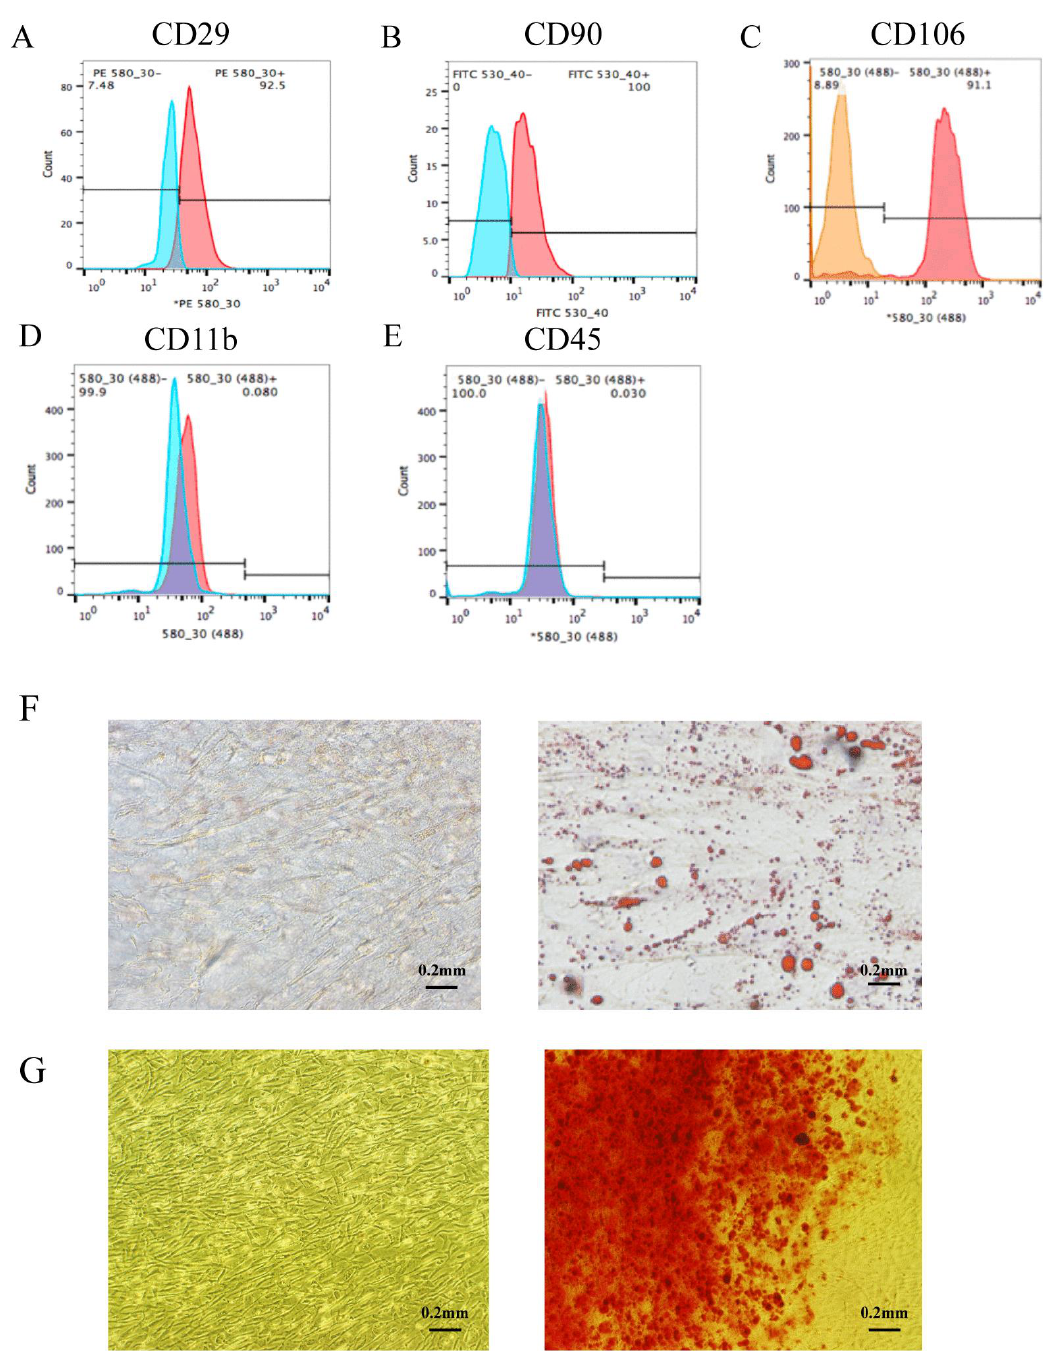
Figure 2. Culture and identification of rat BMSCs. ( A – C ) The positive markers were used to differentiate the stem cells from other cells. The positive rates of CD29, CD90 and CD106 were 92.5%, 100% and 91.1%, respectively. Red line represents the antibody to be tested, and blue or orange line represents the homotypic control. ( D , E ) The negative markers CD11b and CD45 were used to distinguish mesenchymal stem cells from hematopoietic stem cells. The positive rates of CD11b and CD45 were 0.080% and 0.030%, respectively. Red line represents the antibody to be tested, and blue line represents the homotypic control. ( F ) Adipogenic induction and Oil Red O staining; ( G ) Osteogenic induction and Alizarin Red S